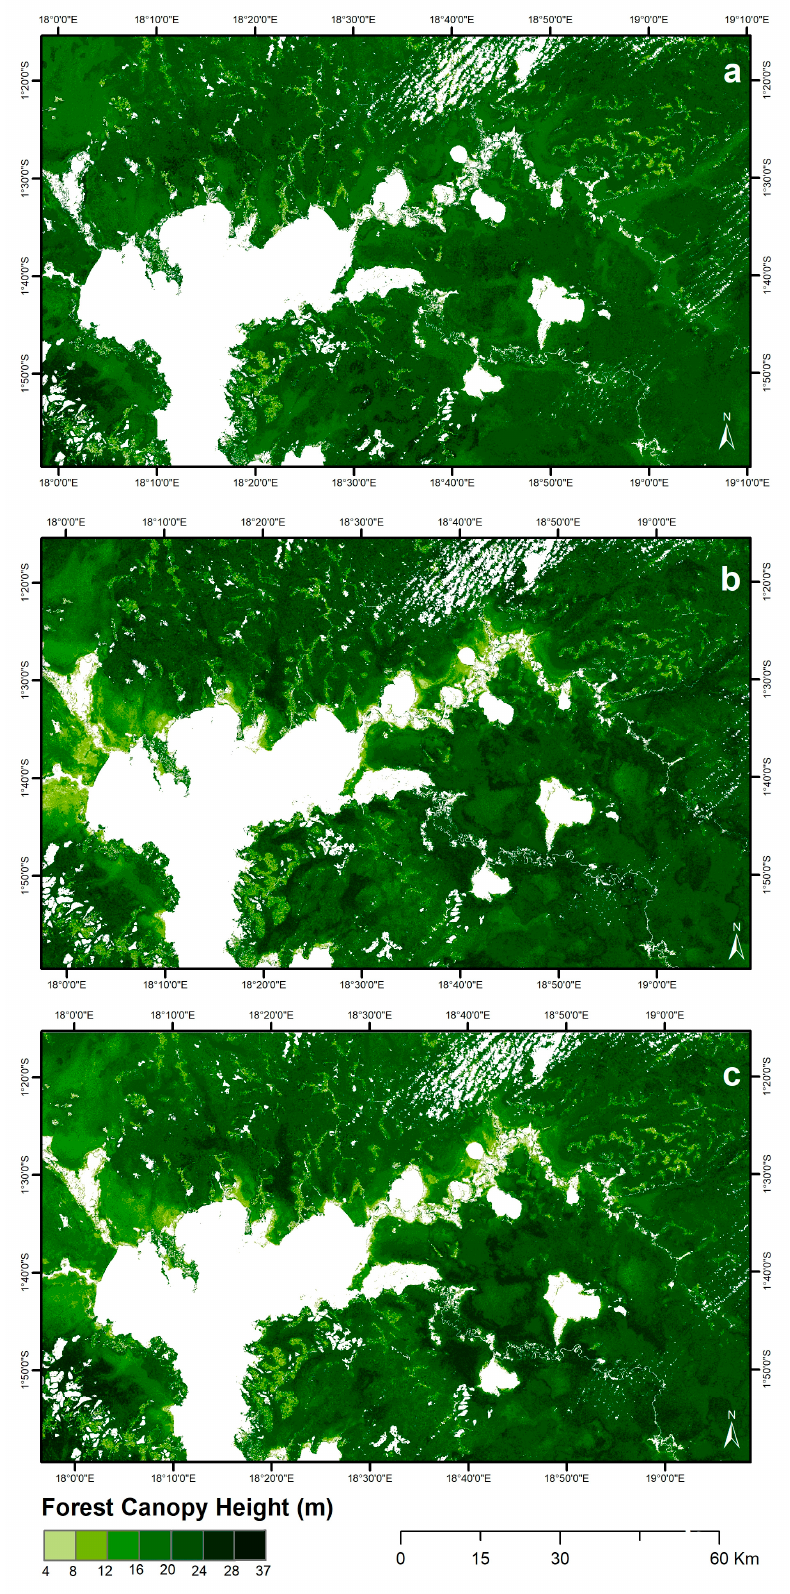
Figure 4. Predicted 30 m dominant forest canopy height derived by the random forest regression tree using Landsat-8 OLI predictor variables collected from ( a ) the dry season 14 July 2013 Landsat-8 OLI image, ( b ) the wet season 8 December 2014 Landsat-8 OLI image, and ( c ) both